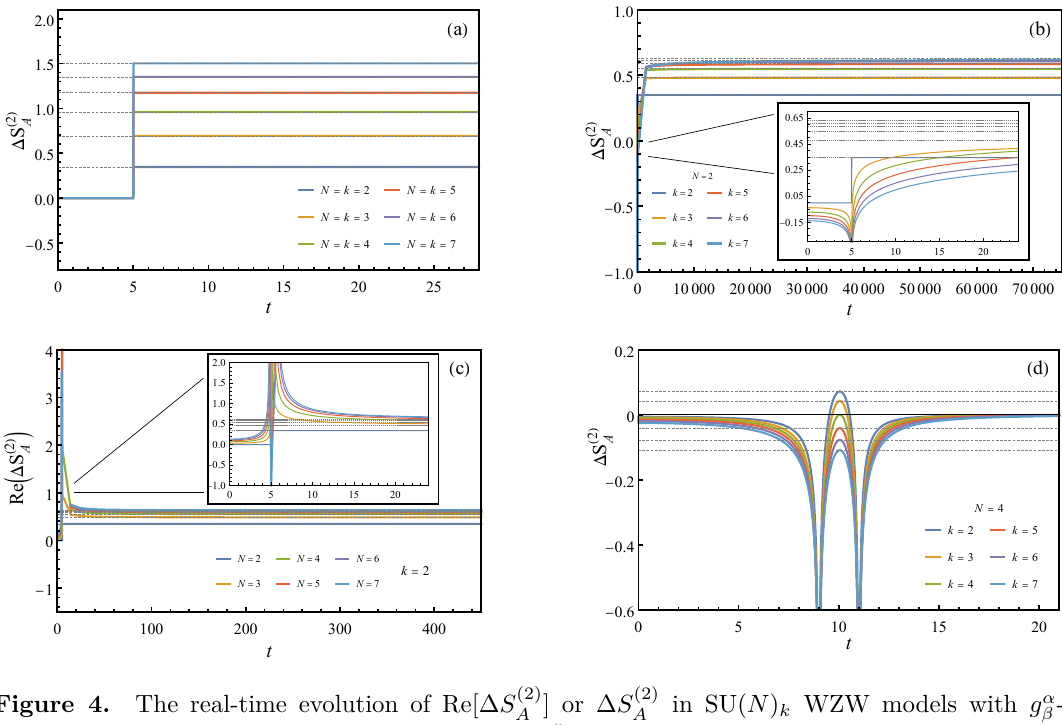
Figure 4. The real-time evolution of Re [∆ S (2) excitation. The regulator is chosen to be (cid:15) = 10 − 5 . (a), (b), (c): A = [0 , ∞ ) , l = 10 , x m = 0 . The dashed lines correspond to log d g for different N and k ; (d): A = [0 , 20] , x m = 10 , l = 2 . ∆ S (2) ( η, ¯ η ) = ∆ S (2) (1 / 2 , 1 / 2) at the dashed A A